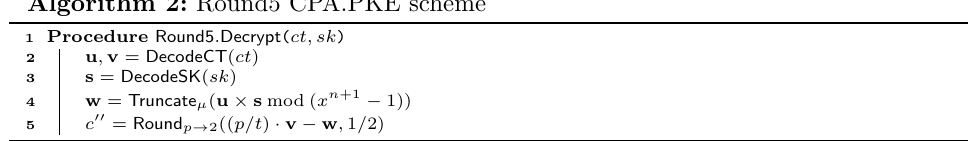
Algorithm 2: Round5 CPA.PKE